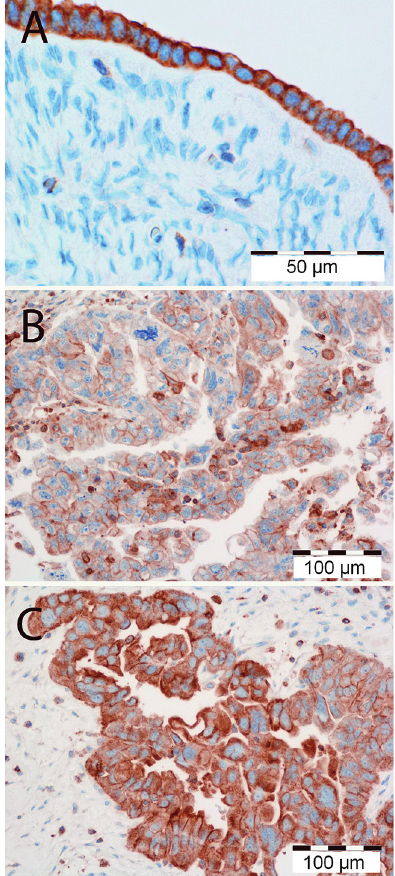
Figure 1. ( A ) High immunohistochemical cytoplasmic/membranous expression of MT1 in normal human ovarian surface epithelium. Magnification ×300. Low ( B ) and high ( C ) immunohistochemical cytoplasmic/membranous expression of MT1 in ovarian cancer